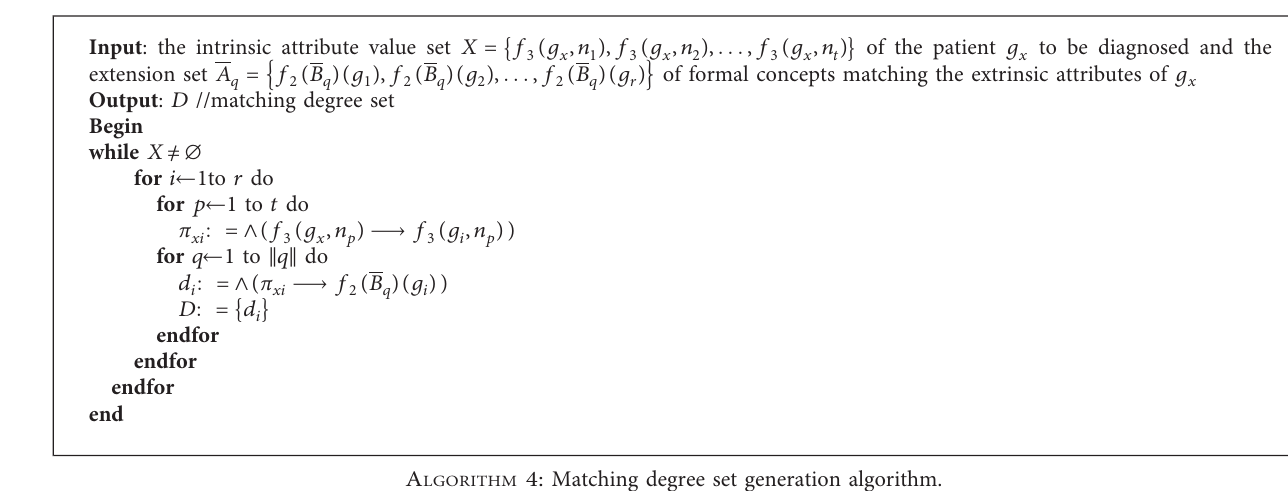
A LGORITHM 4: Matching degree set generation